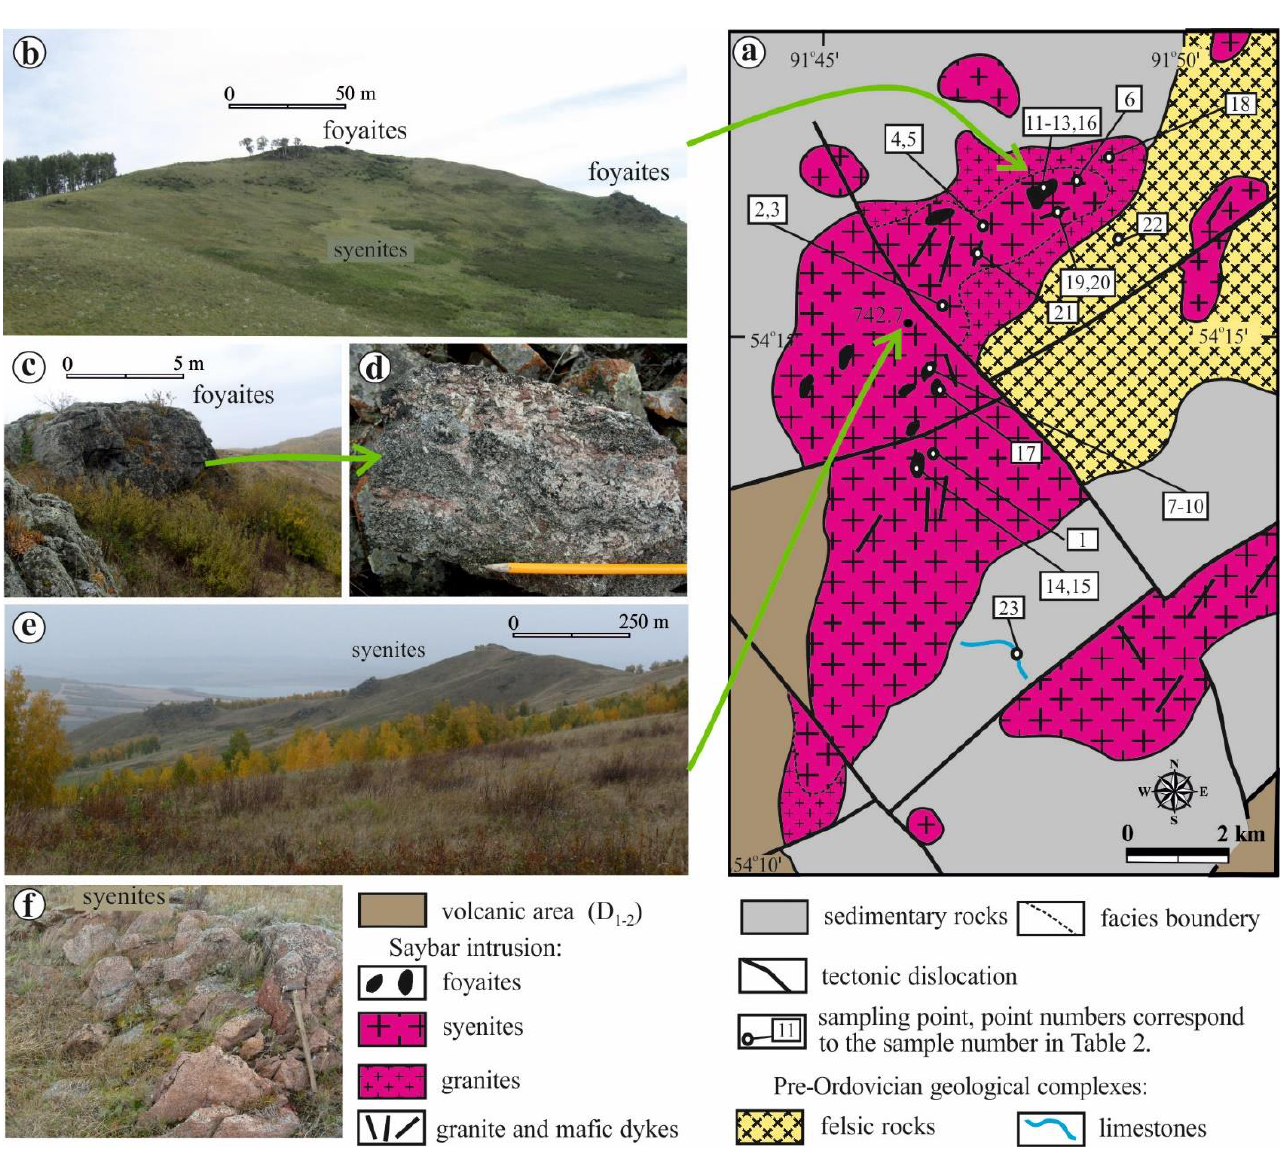
Figure 3. ( a ) Structural geological map of the Saibar intrusion, modified from [49,52–54]. ( b , c ) Representative photos showing that foyaite rocks form small outcrops and ridges elevations above syenites. ( d ) Representative photos showing pegmatoid banded nepheline syenites (foyaites) with alternating leucocratic and melanocratic varieties. ( e ) Panorama of the Saibar intrusion at a height of 742.7 m to the north-east. ( f ) Representative photos of rock outcrop with syenites.